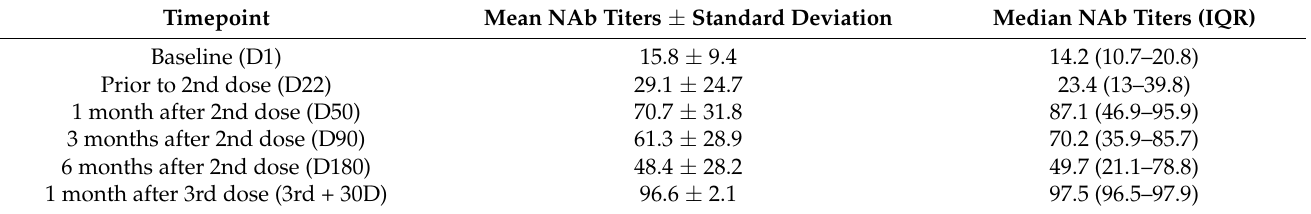
Table 2. Neutralizing antibody (NAb) titers in cancer patients receiving immunotherapy at several timepoints after COVID-19 vaccination.